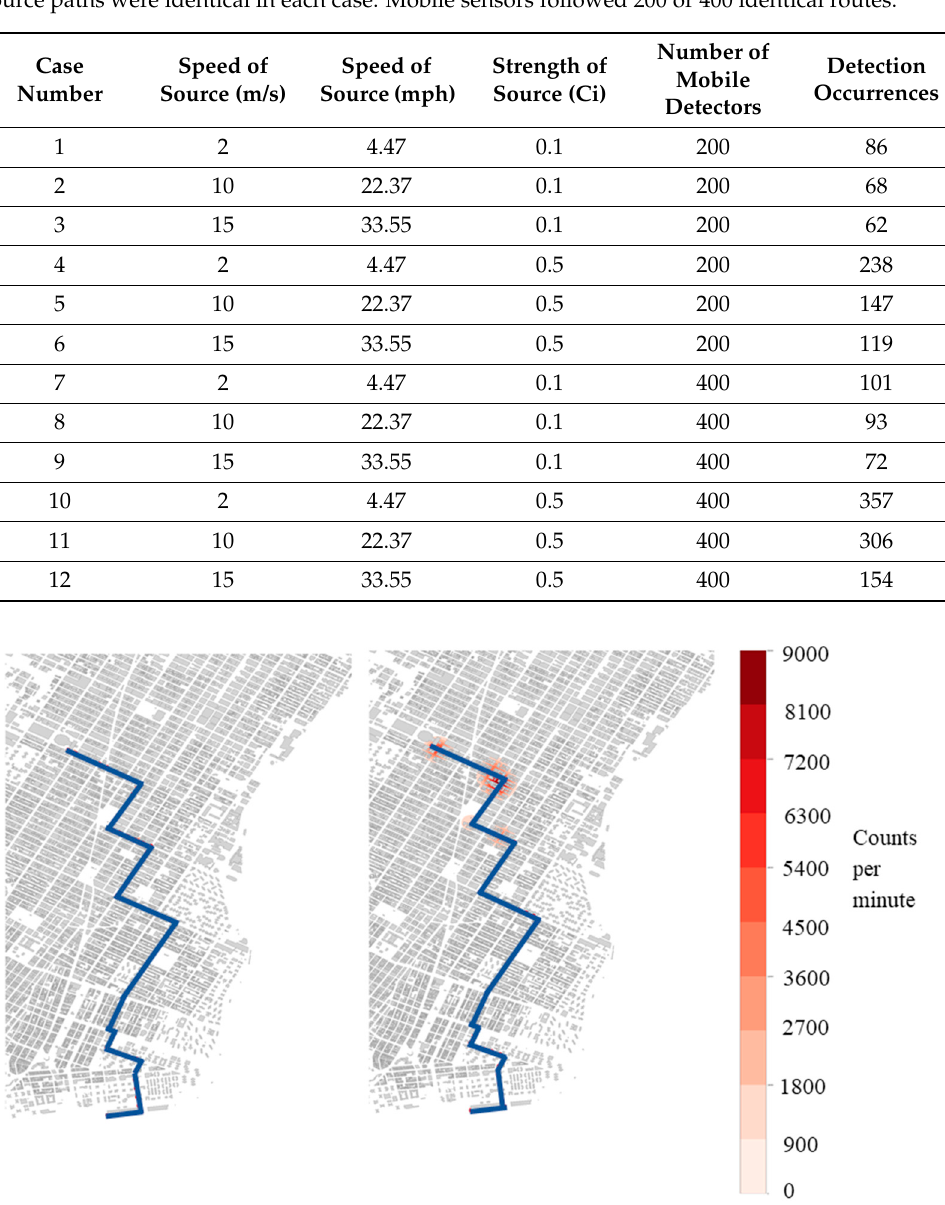
Figure 2. Detection heat maps . The map shows the counts per minute above background detected for a single route for a 200-vehicle mobile detector array of a 0.1 Ci Co-60 (left — case 2) and a 0.5 Ci for a single route for a 200-vehicle mobile detector array of a 0.1 Ci Co-60 ( left —case 2) and a 0.5 Ci Co-60 (right — case 5) source moving at 10 m/s. Co-60 ( right —case 5) source moving at 10